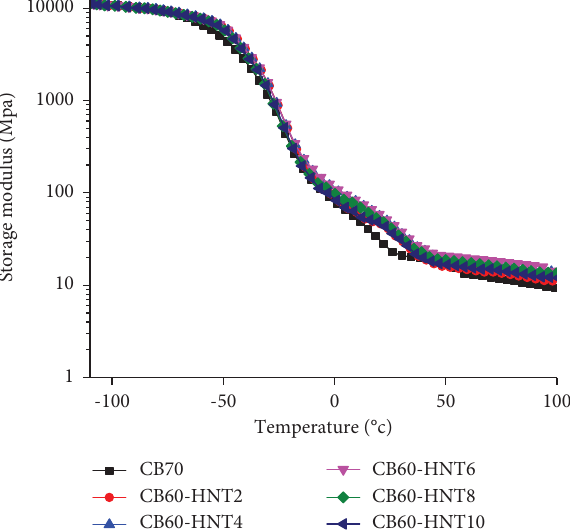
Figure 9: Flynn–Wall–Ozawa plot of ACM-CB70 conventional composites.